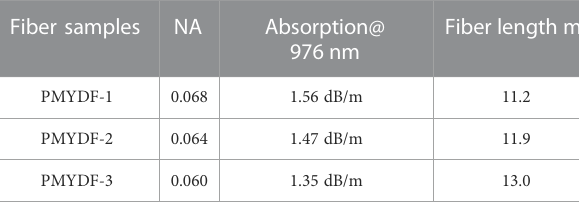
TABLE 1 Characteristic of three different NA